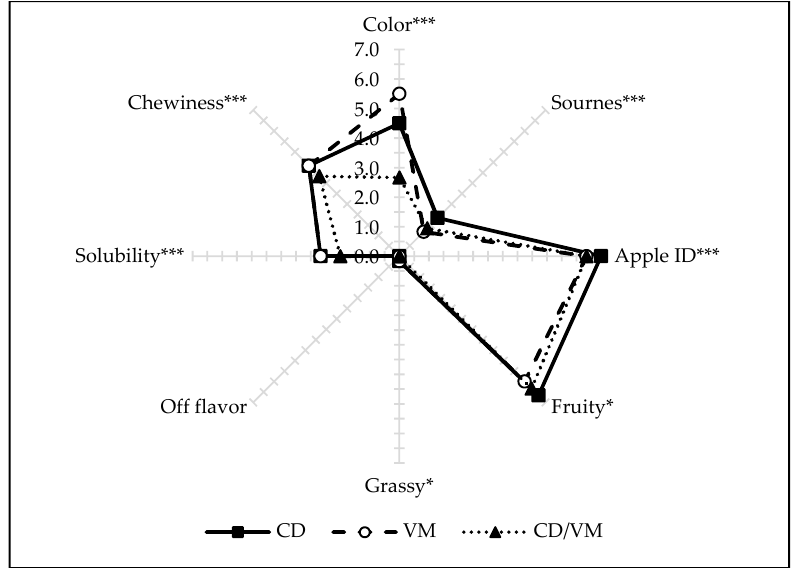
Figure 8. Descriptive sensory analysis of dried apples previously osmo-dehydrated in different solutions with ultrasound pre-treatment for appearance, basic taste, flavor, and texture attributes. *, ** and *** -- significant at p < 0.05, 0.01, and 0.001, respectively.